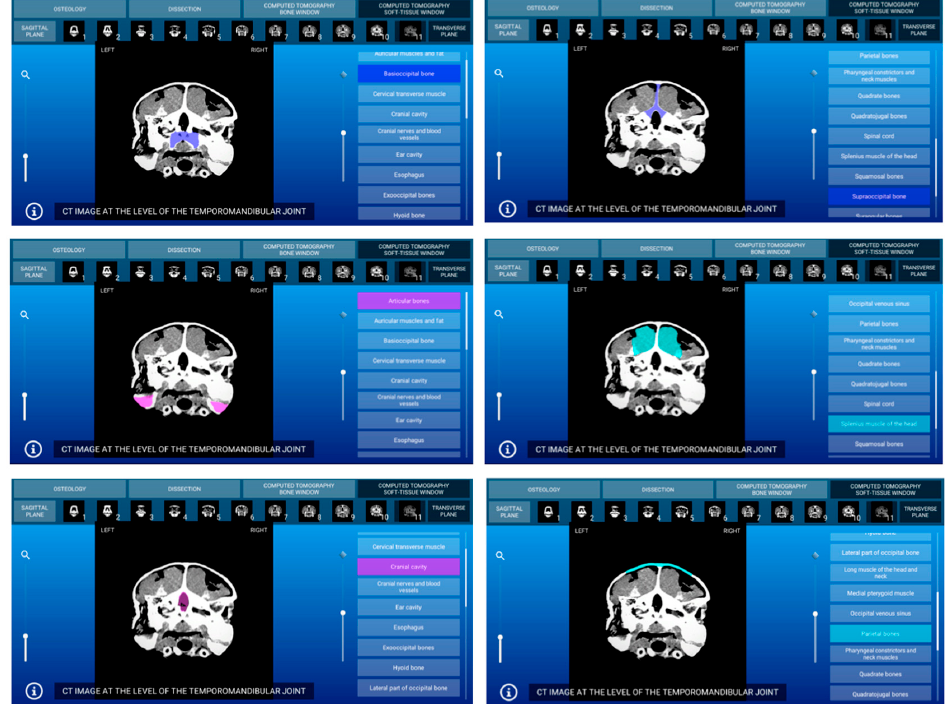
Figure 10. Atlas CT section: an interactive soft tissue window transverse CT image at the level of the temporomandibular joint is shown in caudal aspect.